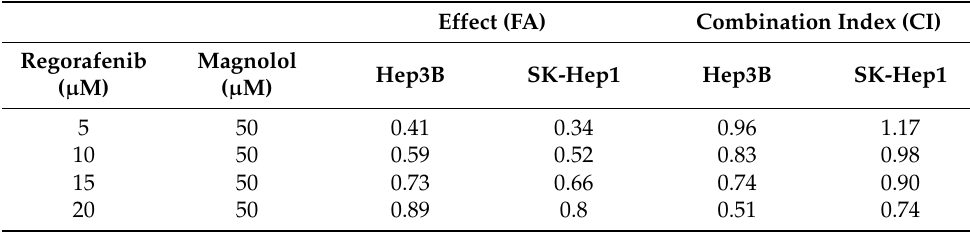
Figure 1. Cytotoxicity of regorafenib was triggered by magnolol. Hep3B and SK-Hep1 cells were treated with ( A ) 0–20 μ M regorafenib, ( B ) 0–100 μ M magnolol, or ( C , D ) 50 μ M magnolol combined with 0–20 μ M regorafenib for 48 hrs and assayed by the MTT assay. The combination index value for 50 μ M magnolol combined with 0–20 μ M regorafenib in ( E ) Hep3B and ( F ) SK-Hep1 cells is presented. The protein expression of CyclinD1, XIAP, C-FLIP, MCL-1, MMP-9, VEGF-A, and MDC-1 is presented after the treatments with magnolol, regorafenib, and a combination in ( G ) Hep3B and ( H ) SK-Hep1 cells. (a 1 p < 0.05 and a 2 p < 0.01 vs. 0 μ M regorafenib or magnolol). Table 1. Combination index data for non-constant combinations.